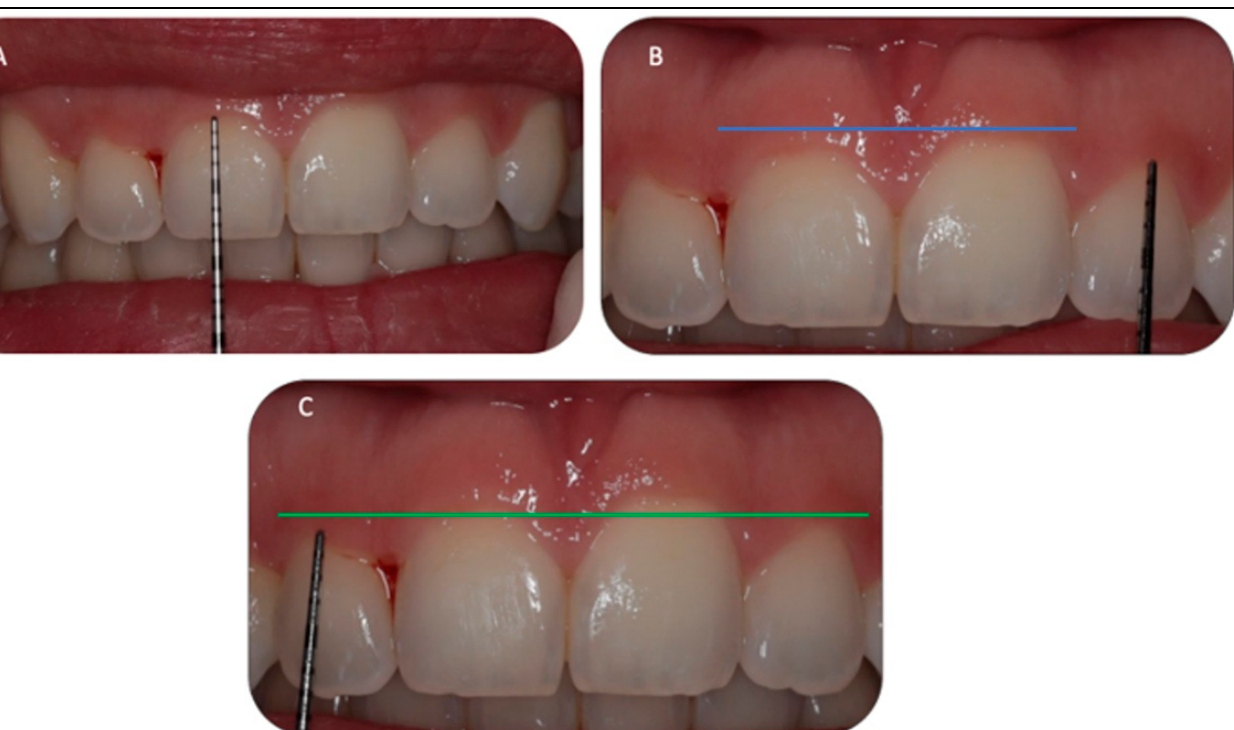
Figure 3. ( A–C ) . Clinical assessment of #11, #12, #21, and #22 revealed gingival overgrowth with no Figure 3. ( A–C ). Clinical assessment of #11, #12, #21, and #22 revealed gingival overgrowth periodontal pocket or inflammation. The biological width was determined by measuring the pro- posed ablative gingival tissues with a periodontal probe and marking the proposed zones with an probe. Biologic width requires the probe to pierce the attachments so that the clinician can accurately measure the distance to the osseous crest. Evidence of pre-operative discrepancy in the level of the gingival margin of the #11, compared to the #21, is highlighted in blue photo ( B ) as well for # 12 and #22, as highlighted in green photo ( C ).